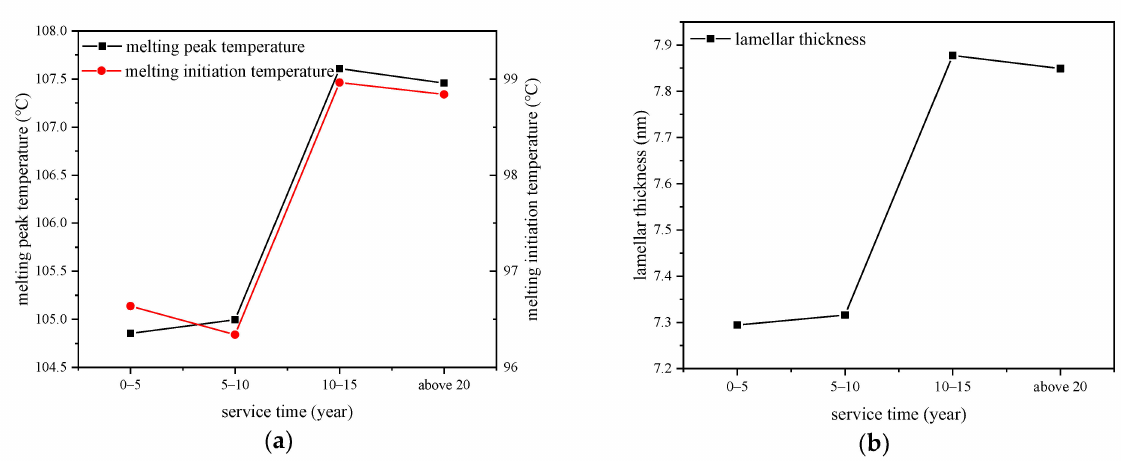
Figure 2. Relationship curves of melting range and crystal lamellar thickness with service time. ( a ) Melting peak and initiation temperatures; ( b ) lamellar